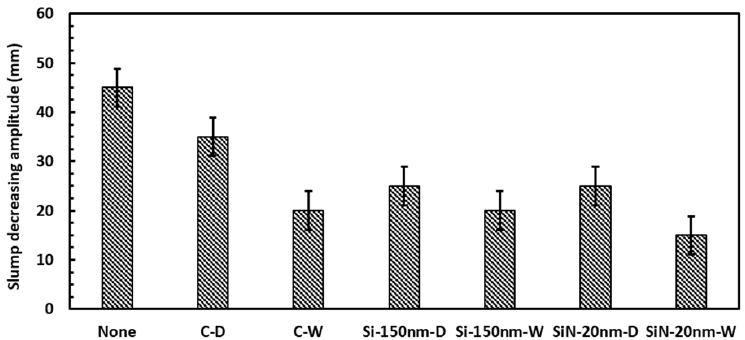
Figure 7. The slump decreasing amplitude of the concretes.